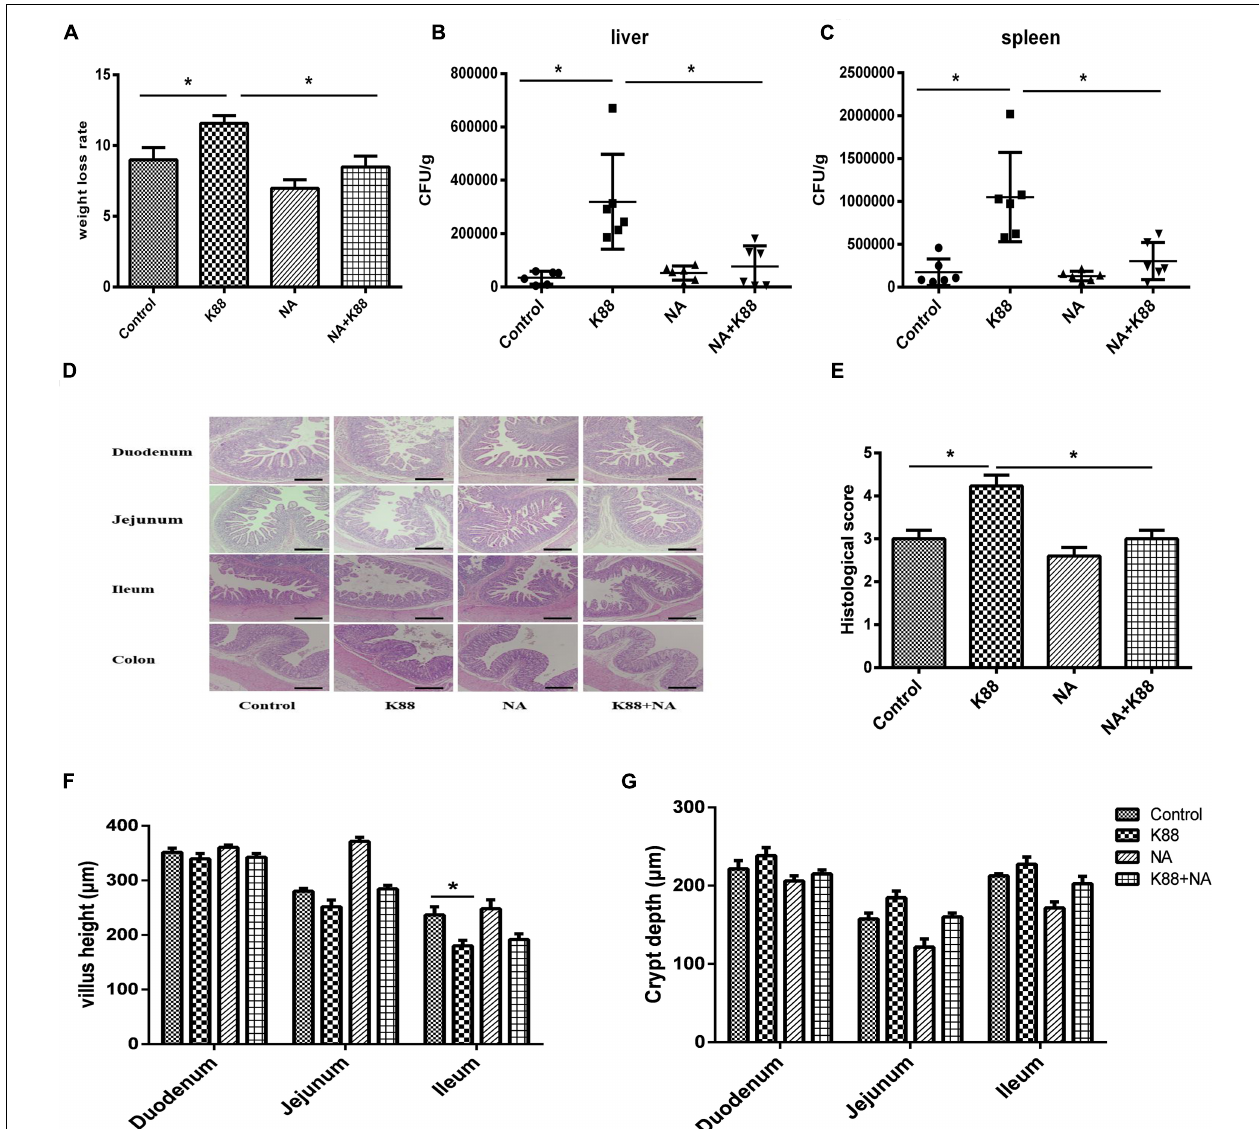
FIGURE 1 | Effects of niacin on body weight loss rate and intestinal morphology caused by Escherichia coli infection of weaned piglets. The weight loss rate of piglets was showed (A) , the number of CFU of the bacteria transfer to the liver (B) and spleen (C) after infection tissues by bacterial plate counting analysis. Stained with H&E (bars, 500 µ m) (D) . Histological scores were determined as described in the Materials and Methods (E) . Villous height in the jejunum, duodenum, and ileum (F) . Crypt depth in the jejunum, duodenum, and ileum (G) . All data are expressed as the mean ± SEM. * P < 0.05.